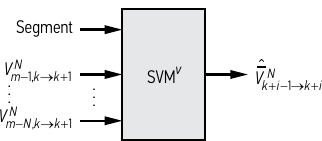
Fig. 4. The structure of the average bus speed prediction model on a further